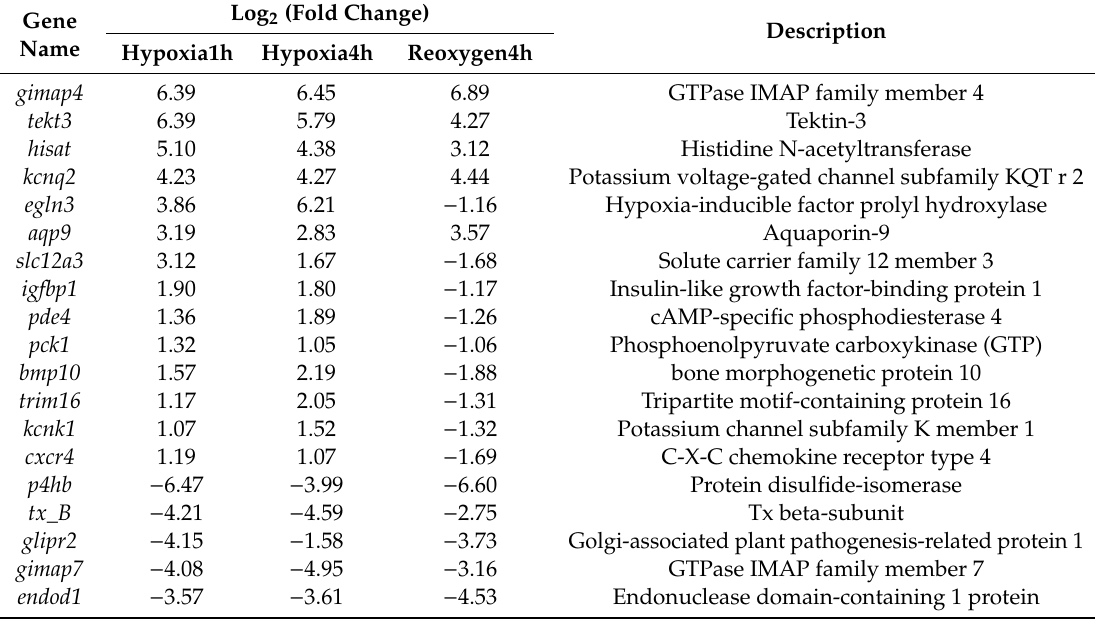
Table 2. Annotation of the top ten di ff erential expression genes in three treatment groups (padj < 0.05).